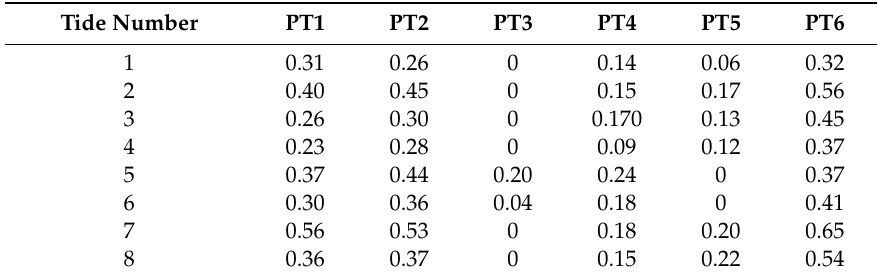
Table 4. Longshore significant wave height reductions (m) compared to maximum measured significant wave height for deployment 2.